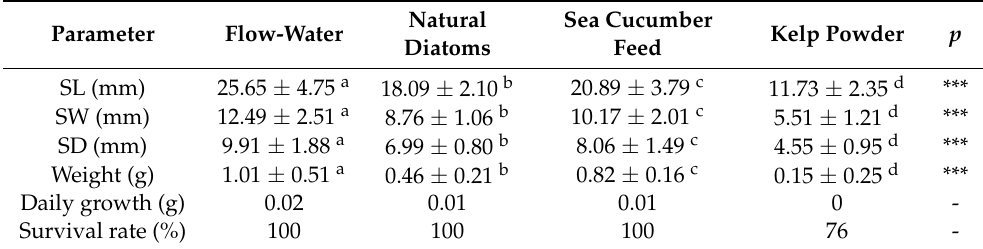
Table 2. Laevistrombus canarium . Mean ( ± sd) values of weight, shell length, shell width, shell depth, survival rate, and daily growth rate of 10-mm juveniles after 56 days of feeding on four diets (flow water, natural diatoms, sea cucumber feed, kelp